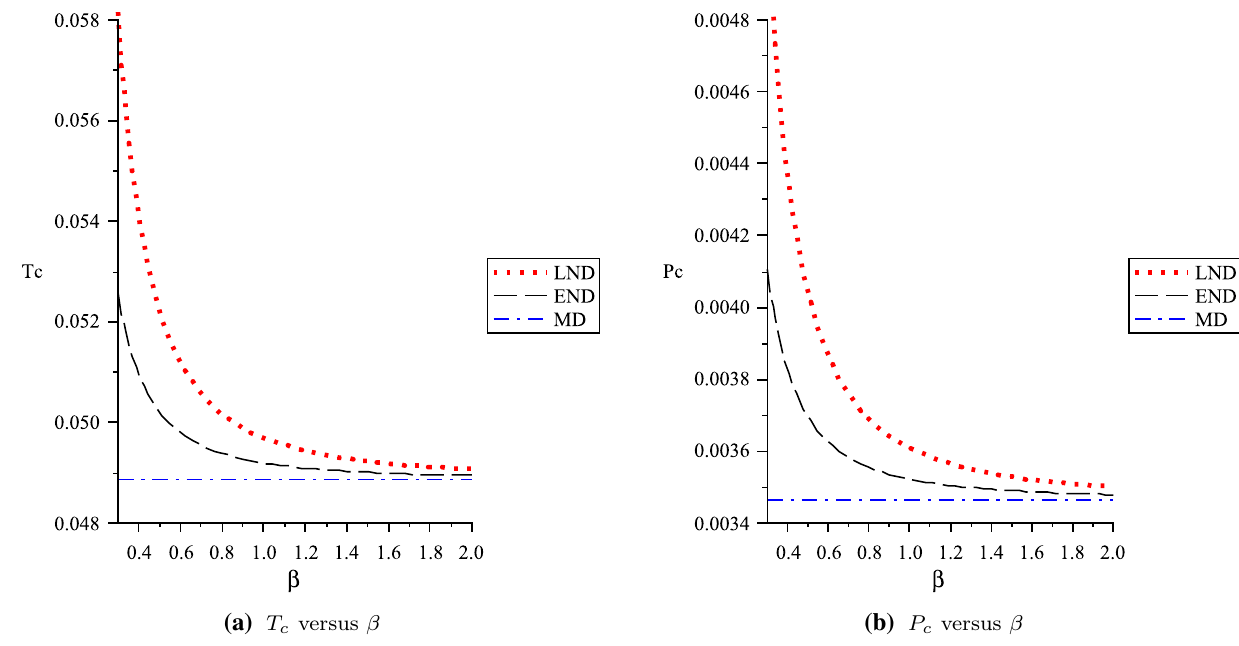
Fig. 4 Critical quantities of dilaton black holes. Here we have set q = b = k = 1 and α = 0 .